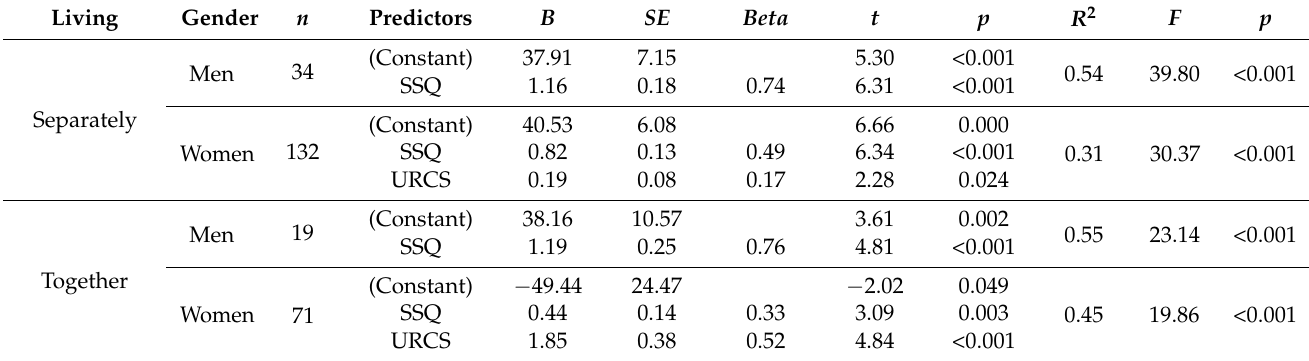
Table 6. Relationship satisfaction